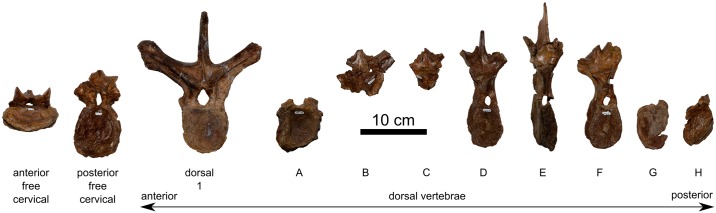
Vertebrae of Spiclypeus shipporum gen et sp. nov. (CMN 57081) in anterior view.Vertebrae A–H are dorsals of indeterminate position.